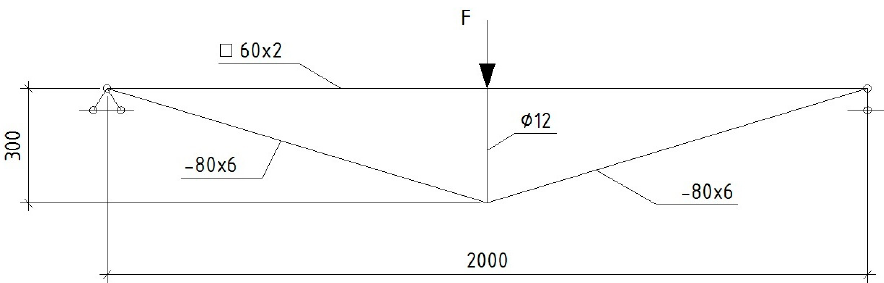
Figure 4. Geometric scheme of truss No. 2 (destruction of the lower chord). To measure deformations, FLA-5-11 strain gauges with a base of 5 × 1.5 mm and a resistance of 120 Ohm were glued to the truss. Strain gauges were installed in the middle of each element of the upper and lower truss chords on the upper and lower edges. The total number of sensors was 12 pcs. for each truss. Vertical displacements were measured using an inductive linear displacement transducer CDP-25 (rod stroke 0–25 mm) installed in the middle of the span of the upper chord of the truss and secured with a clamp. Addi- tionally, during experiment No. 3 two more inductive linear displacement transducers CDP-25 were placed in the center of each of the panels of the upper chord. The arrange- ment and numbers of strain gauges and de fl ection gauges for truss No. 1 are shown in Figure 5. The numbers in brackets refer to the gauges glued to the underside of the ele- ment. Figure 5. Layout and numbering of sensors on the truss in experiment No. 1. The load was applied step-by-step by placing weights of 0.2 kN and 0.125 kN on a specially designed cargo platform suspended from the upper chord of the truss. The sub- sequent stages of loading began after the complete a tt enuation of the vibrations of the structure of the tested truss caused by the previous stage. The trusses were hinged on stationary inventory supports. Inventory supports were rigidly a tt ached to the power fl oor of the laboratory. In the support nodes of the trusses, corners with a fi xing plate were welded, which prevented the truss from displacing from the support when it was de- stroyed. The trusses were installed on supports so that there were 5–10 mm gaps between the vertical fi xing plates at both ends of the truss (Figure 6).